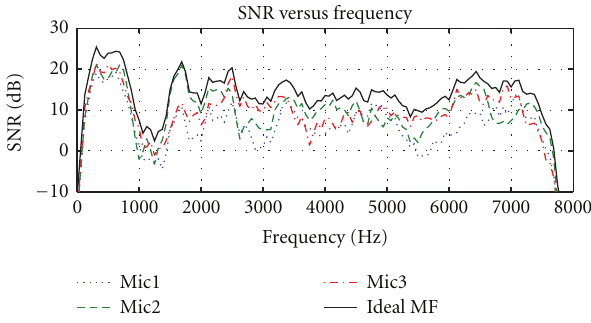
Figure 3: Input SNR for a conference scenario with background noise.